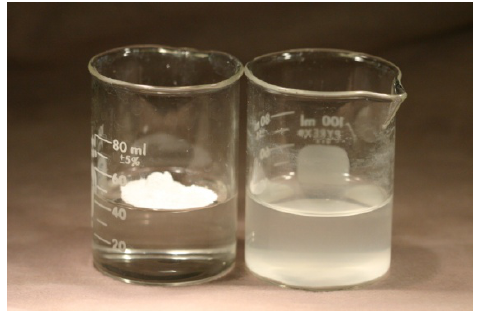
Figure 4. Two jars of water to which equal amounts of silica glass particles (size ~ 1–2 μ m) were added. The particles added to the water in the left jar had been pretreated with γ -MPS, while the ones in the right jar had not received any treatment. Despite a particle density of 2.8 g/cm 3 , the silane treated particles float on the water surface because of their hydrophobic coating, while the untreated particles sedimented into the water. Photo was taken 1 h after particles were added to